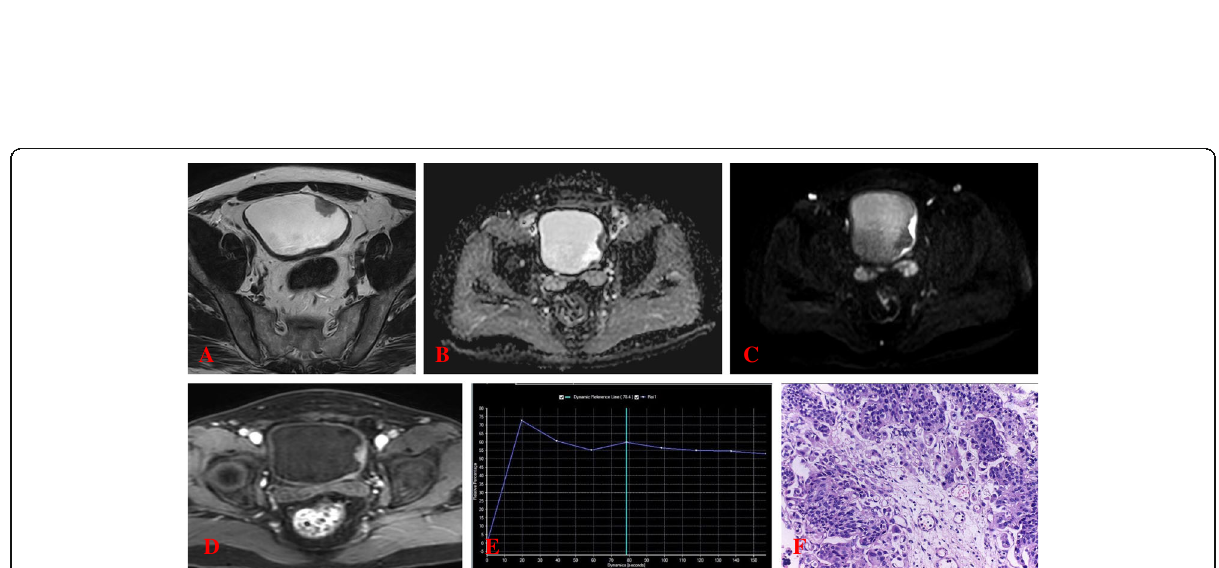
Fig. 4 A 57-year-old male patient presented with history of recurrent hematuria. Axial T2 WI ( a ) showed an intra-vesical soft tissue masses arising from left lateral and left postero-lateral bladder wall expressing intermediate signal intensity with no interruption of the hypointense underlying muscle layer. Axial ADC map ( b ) showed low SI of the lesion with ADC value = 0.8 × 10 − 3 mm 2 /s, consistent with high-grade tumor. Axial DW- MRI (b1000) ( c ) showed restricted diffusion of the masses with intact underlying low SI muscle layer. Axial post contrast T1WI FAT-SAT ( d ) showed early enhancement of the masses with intact underlying muscle layer and preserved submucosal linear enhancement. Time-intensity curve ( e ) showed grade 3 curve with early enhancement and rapid washout. Multiparametric MRI features suggest high-grade stage T1 non-muscle- invasive urinary bladder carcinoma. Microscopic image of histopathology ( f ) demonstrated high-grade urothelial carcinoma which confirm the multiparametric MRI